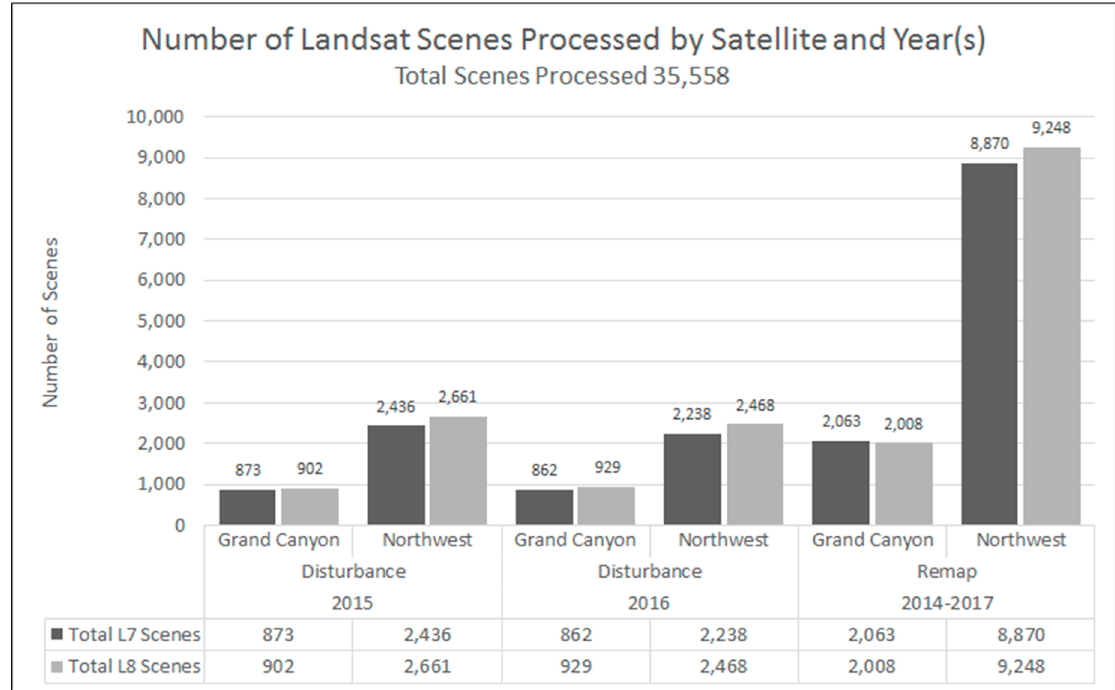
Figure 2. Number of Landsat scenes processed for the disturbance and Remap vegetation mapping products circa 2015 within Grand Canyon and Northwest prototype areas. The number of scenes processed is further broken down by Landsat sensor, including Enhanced Thematic Mapper Plus (ETM+, L7) and Operational Land Imager (OLI, L8).